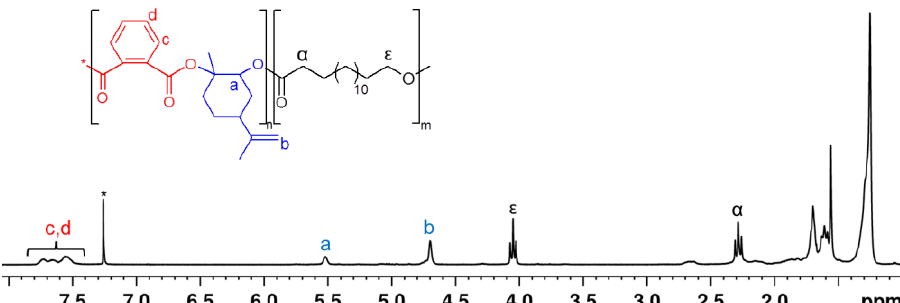
Figure 3. 1 HNMR (600 MHz, CDCl 3 , RT) of poly(limonene-phthalate)- block -poly(pentadecalactone). The signals in the spectrum have been assigned to the proper hydrogen, as indicated in the structure.